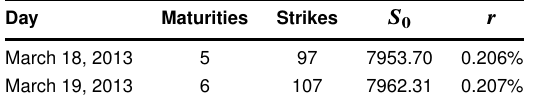
Table 1. Real market data